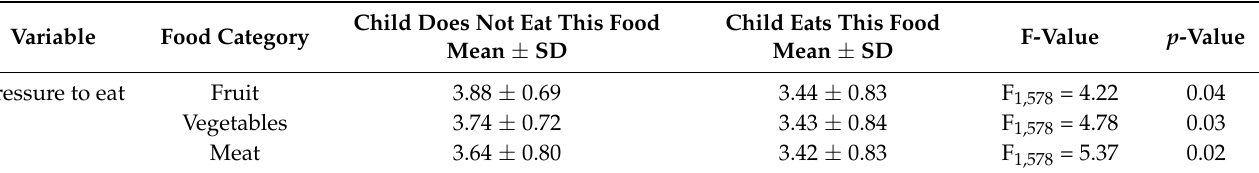
Table 6. One-way ANOVA testing for the effects of the introduction of several food categories on the pressure to eat in infants and toddlers from 6–18 months old, n = 580. Only significant results are